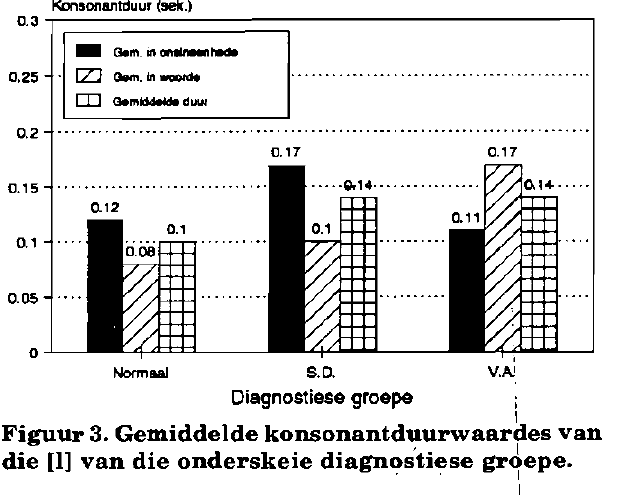
Figuur 3. Gemiddelde konsonantduurwaardes van die [1] van die onderskeie diagnostiese groepe. Konsonantduur (sek.)